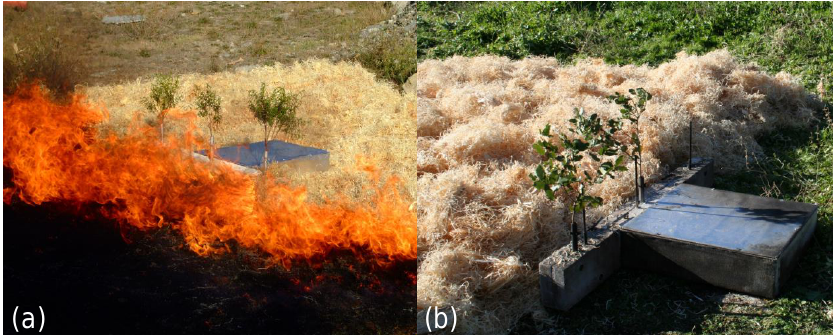
Figure 4. Differential mass-loss prototype placed in the middle (a) and at the end (b) of the fuel